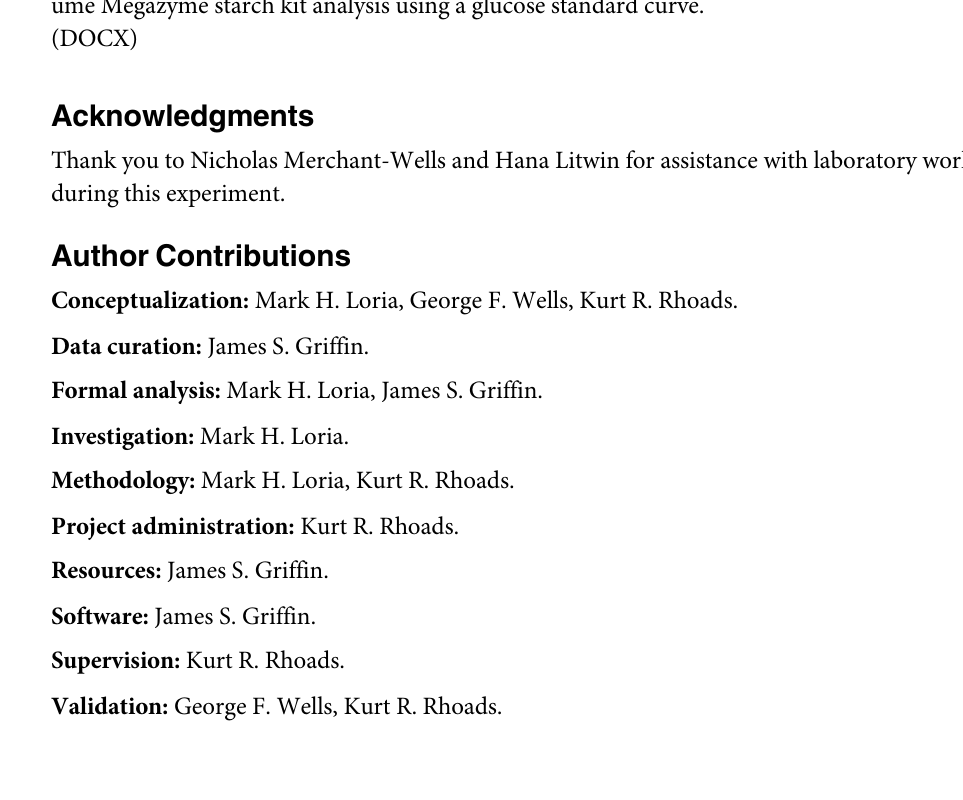
S1 Table. Quality check of modified starch extraction method. Repeatability in replicates of flour standards and algal samples as indicated by measured % starch by dry weight (% dw) using scaled-down reaction volumes. S1 Fig. Linearity check of modified starch extraction method. Test of linearity of lower-vol- ume Megazyme starch kit analysis using a glucose standard